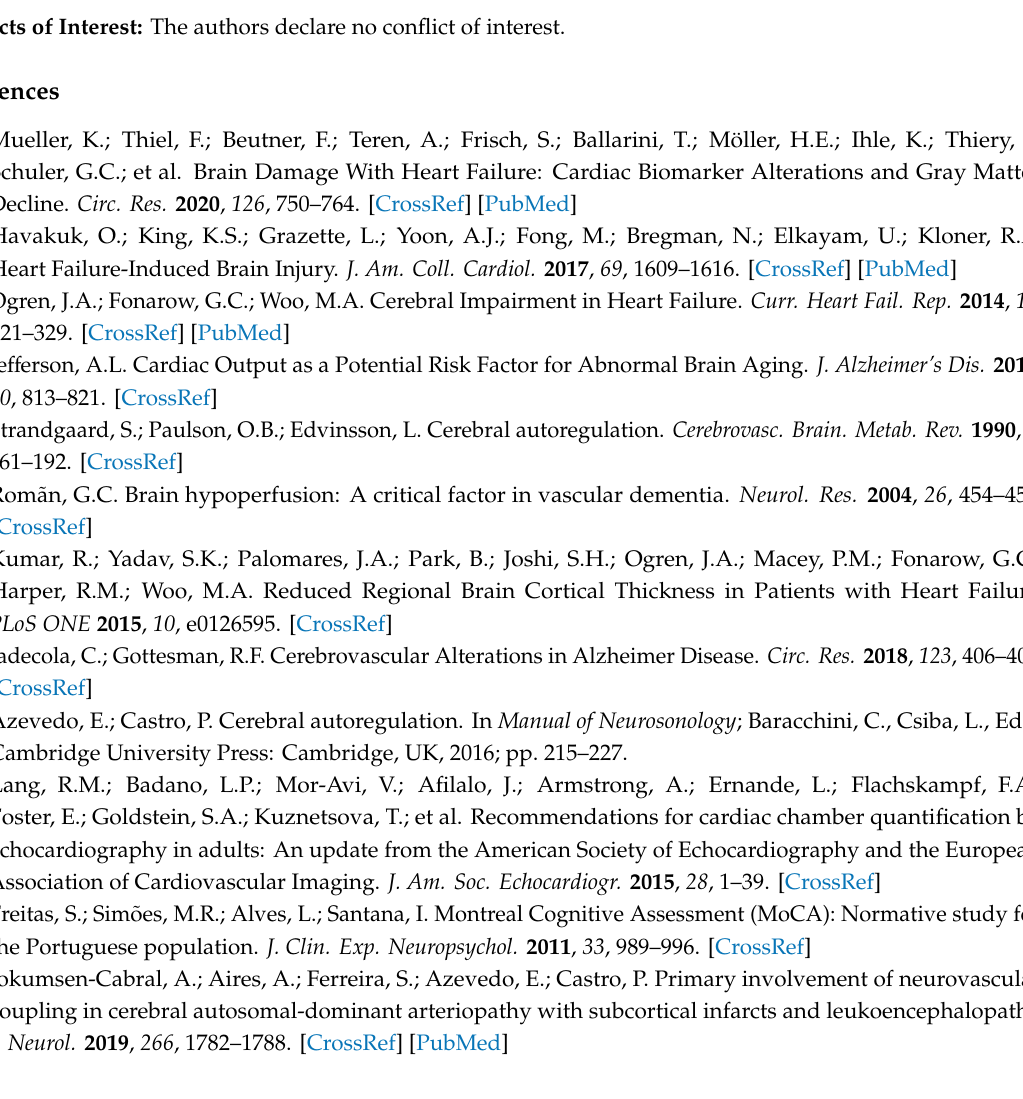
Table S1: HF etiology e ff ect on neurovascular coupling (NVC) in heart failure (HF)